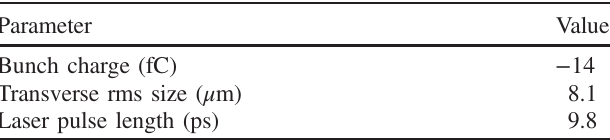
TABLE II. NCRF beam line simulation beam parameters.